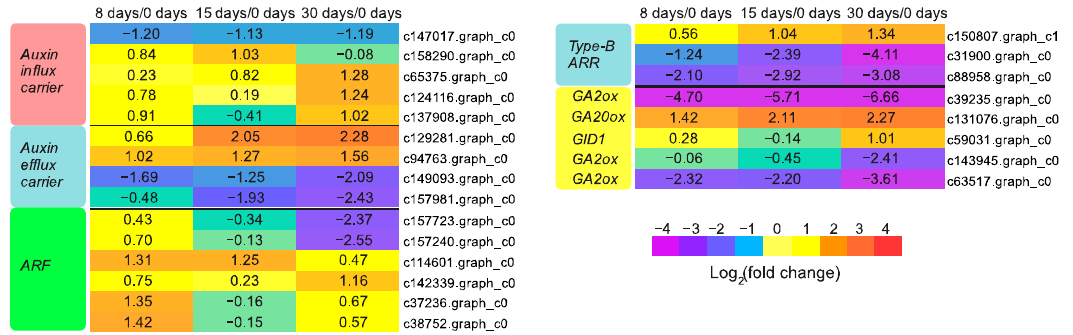
Figure 5. Expression patterns of DEGs involved in hormone signaling. The values of log 2 fold change are shown in the heat map.